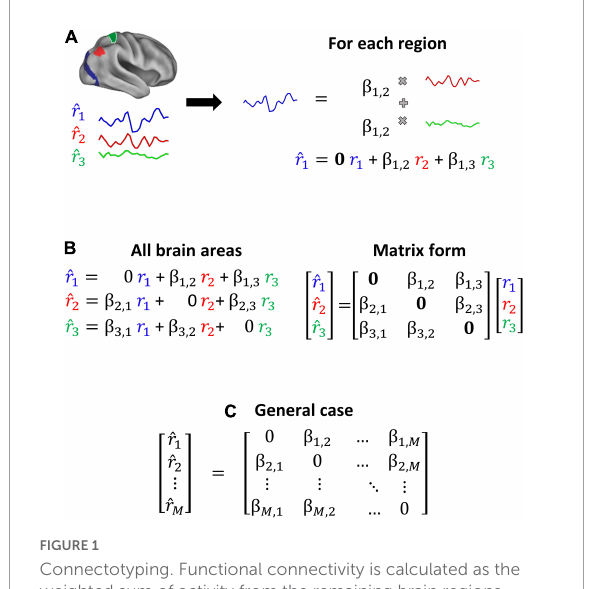
FIGURE1 Connectotyping. Functional connectivity is calculated as the weighted sum of activity from the remaining brain regions (Miranda-Dominguez et al., 2014a). (A) Given 3 brain areas, each timeseries is modeled as the weighted sum of the other timeseries. (B) All the equations can be expressed as a matrix and solved using linear algebra. (C) This approach can be generalized to M brain